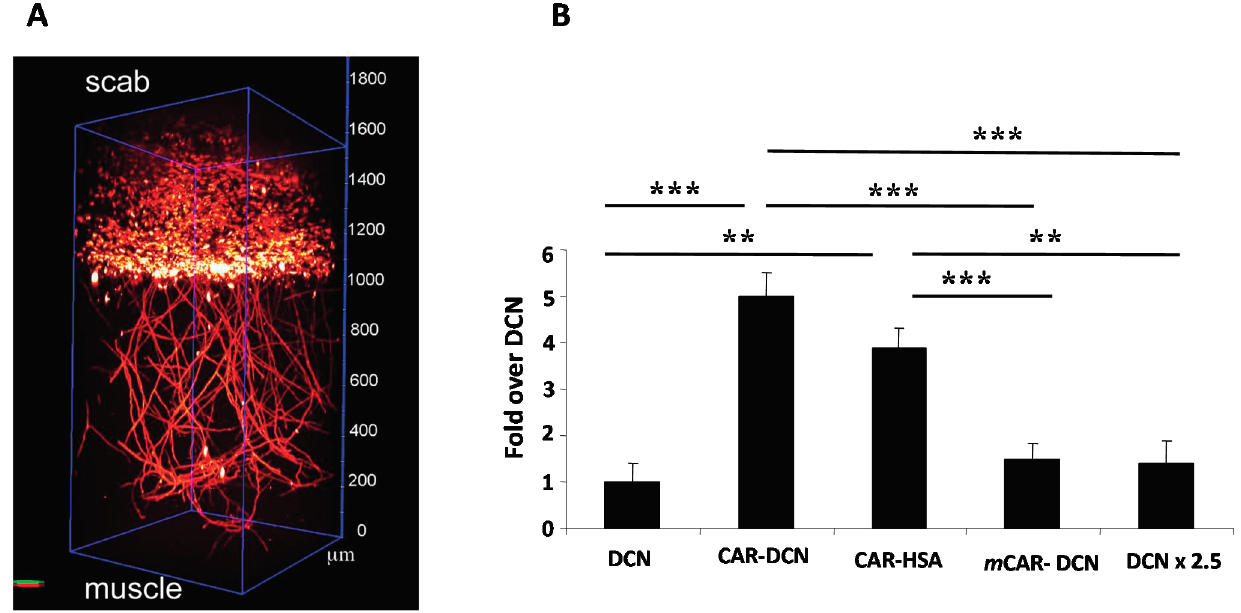
Figure 6. Targeted delivery of systemically administered therapeutics to the regenerating tissues. ( A ) 2-Photon fluorescence microscopy of vascular homing peptide accumulation to wound vasculature illustrates the specificity of the vascular targeting [30]. 2-Photon fluorescence microscope allows 3-D imaging of whole tissues [30]; and ( B ) Mice with full thickness skin wounds received an i.v. injection of His-tagged fusion proteins. The location of decorin was determined with an anti–His-tag antibody. The wounds of mice injected with non-targeted decorin (DCN) or mutant CAR peptide coupled decorin ( m CAR-DCN) were weakly positive, whereas strong wound staining was observed in CAR-DCN injected mice [39]. The accumulation of CAR fused to human serum albumin (CAR-HSA) in the wounds confirmed the ability of the CAR peptide to enhance targeting to the wounds in fusion proteins other than DCN [39]. No staining was observed in normal skeletal muscle underlying the skin wounds of mice treated with any of the decorins. The staining was quantified by digital histology. The statistical significance was examined with ANOVA; ** p ≤ 0.01, *** p < 0.001